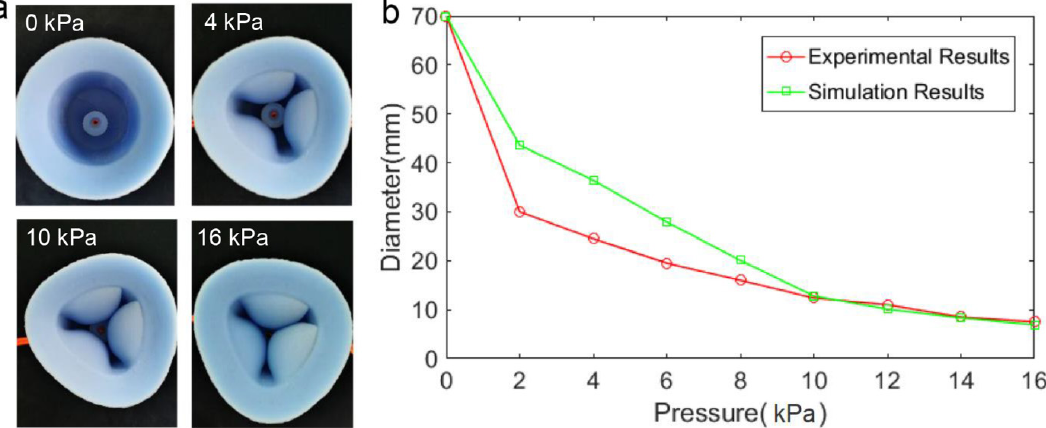
Figure 6. Grasping range of the cylindrical soft actuator. ( a ) The inflated state of the cylindrical soft actuator at 0 kPa, 4 kPa, 10 kPa and 16 kPa respectively. ( b ) The relationship between inscribed circle diameters and input pressures of experimental results and simulation results.